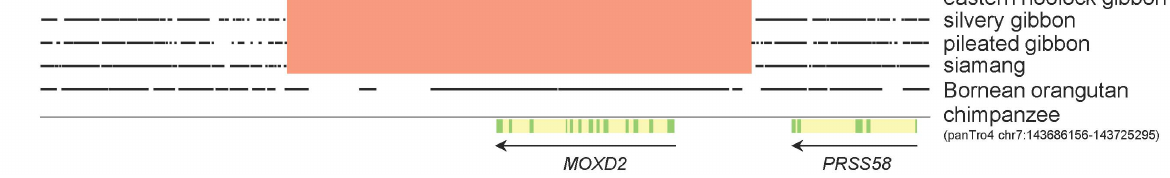
Figure 2. Complete deletion of the MOXD2 gene in gibbons. (A) Dot plots between the olive baboon MOXD2 - PRSS58 genomic locus and orthologous regions from five other primate species (the rhesus macaque, the northern white-cheeked gibbon, the western lowland gorilla, the chimpanzee, and the human) are depicted. The northern white-cheeked gibbon MOXD2 gene is replaced by a translocated DNA fragment (red box). The locations of the MOXD2 and PRSS58 genes are indicated at the right (downward arrows), with coding regions and noncoding regions (introns and untranslated regions) in green and yellow, respectively. The human genomic segment containing MOXD2 exons 12 and 13 was deleted after the human-chimpanzee divergence (red vertical line). Gray vertical lines in the rhesus macaque and the northern white-cheeked gibbon genomes mark short assembly gaps. Blue arrows indicate chromosome direction (from p- to q-telomere). (B) Deletion of MOXD2 gene in four other gibbon species. WGS reads from the hoolock gibbon, the silvery gibbon, the pileated gibbon, the siamang, and the Bornean orangutan were mapped to the repeat- masked chimpanzee MOXD2-PRSS58 genomic sequence. Where matched WGS read positions are marked with dots, the MOXD2 gene region (red box) lacked matching gibbon WGS reads but not orangutan WGS reads, indicating that the region is missing in these four gibbon species. The locations of the MOXD2 and PRSS58 genes are indicated at the bottom with coding and noncoding regions in green and yellow, respectively. Parentheses indicate the genome assembly version and position for each species available from the UCSC Genome Browser database.